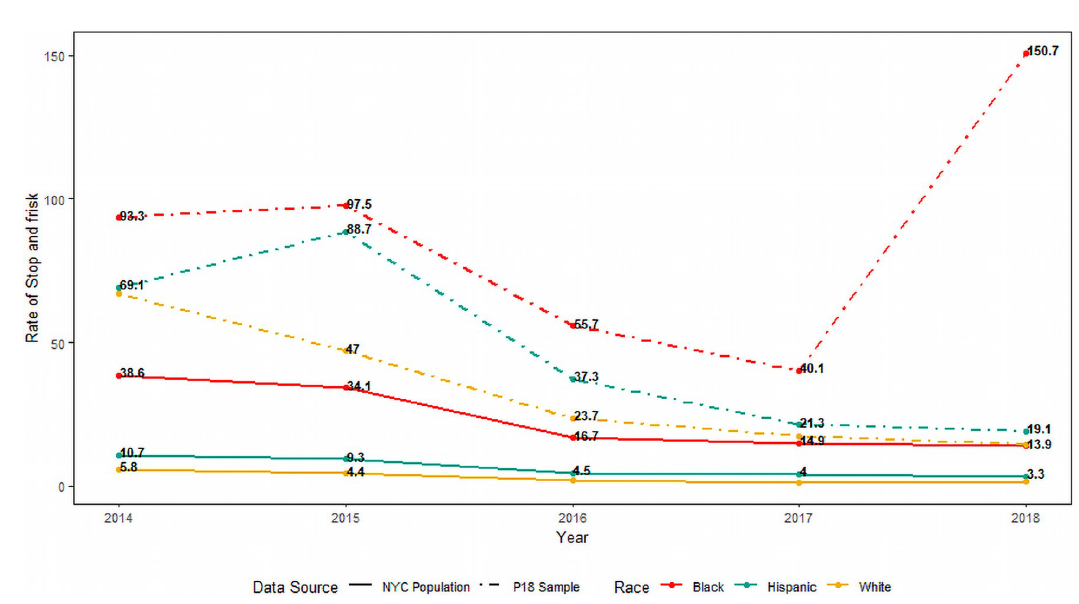
Fig 2. Stop-and-frisk rate per 1,000 population � reported by P18 participants vs recorded by the New York City Police Department (NYPD), by race. � P18 rates were calculated as the race-specific number of stop-and-frisk events reported by P18 participants/race-specific P18 study population. These were compared to rates in the general population, calculated as the race- specific number of stop-and-frisk events recorded by the New York City Police Department/race-specific American Community Survey New York City population estimates. Note: Rate among Black P18 participants at the 36-month visit was driven by a high stop rate among one participant (66 stops in the past year); when this participant was excluded from the analysis the stop rate was reduced to 58.6 per